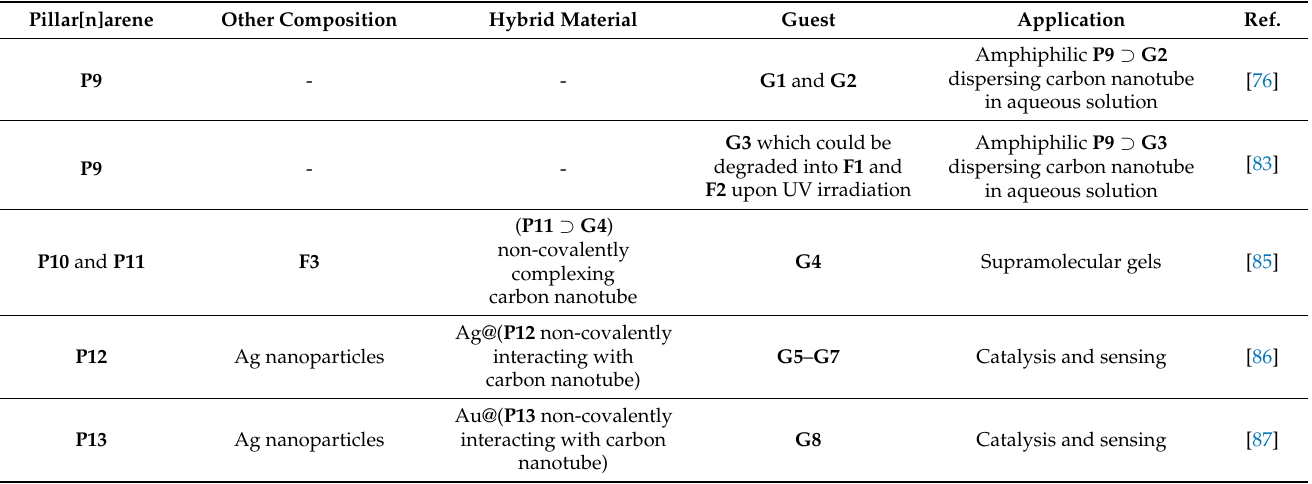
Table 1. Fabrication of carbon nanotube-based hybrid materials by using different functional pillar[n]arene, other diverse compositions, various guests for applications such as gels, sensing and catalysis.